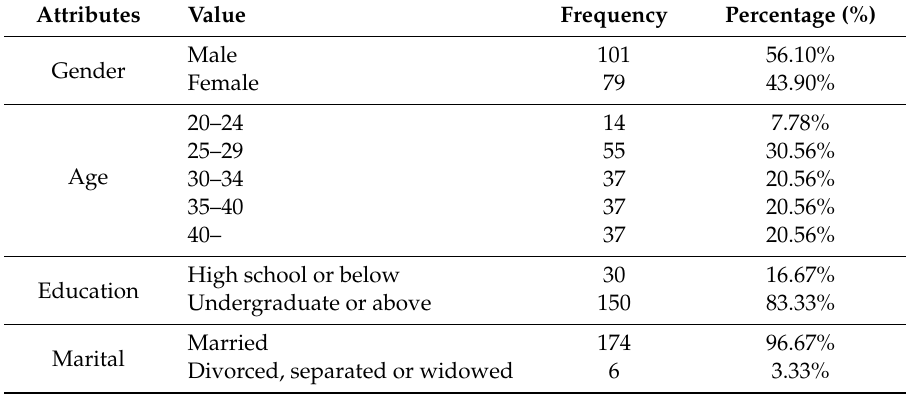
Table 2. Demographic characteristics of the